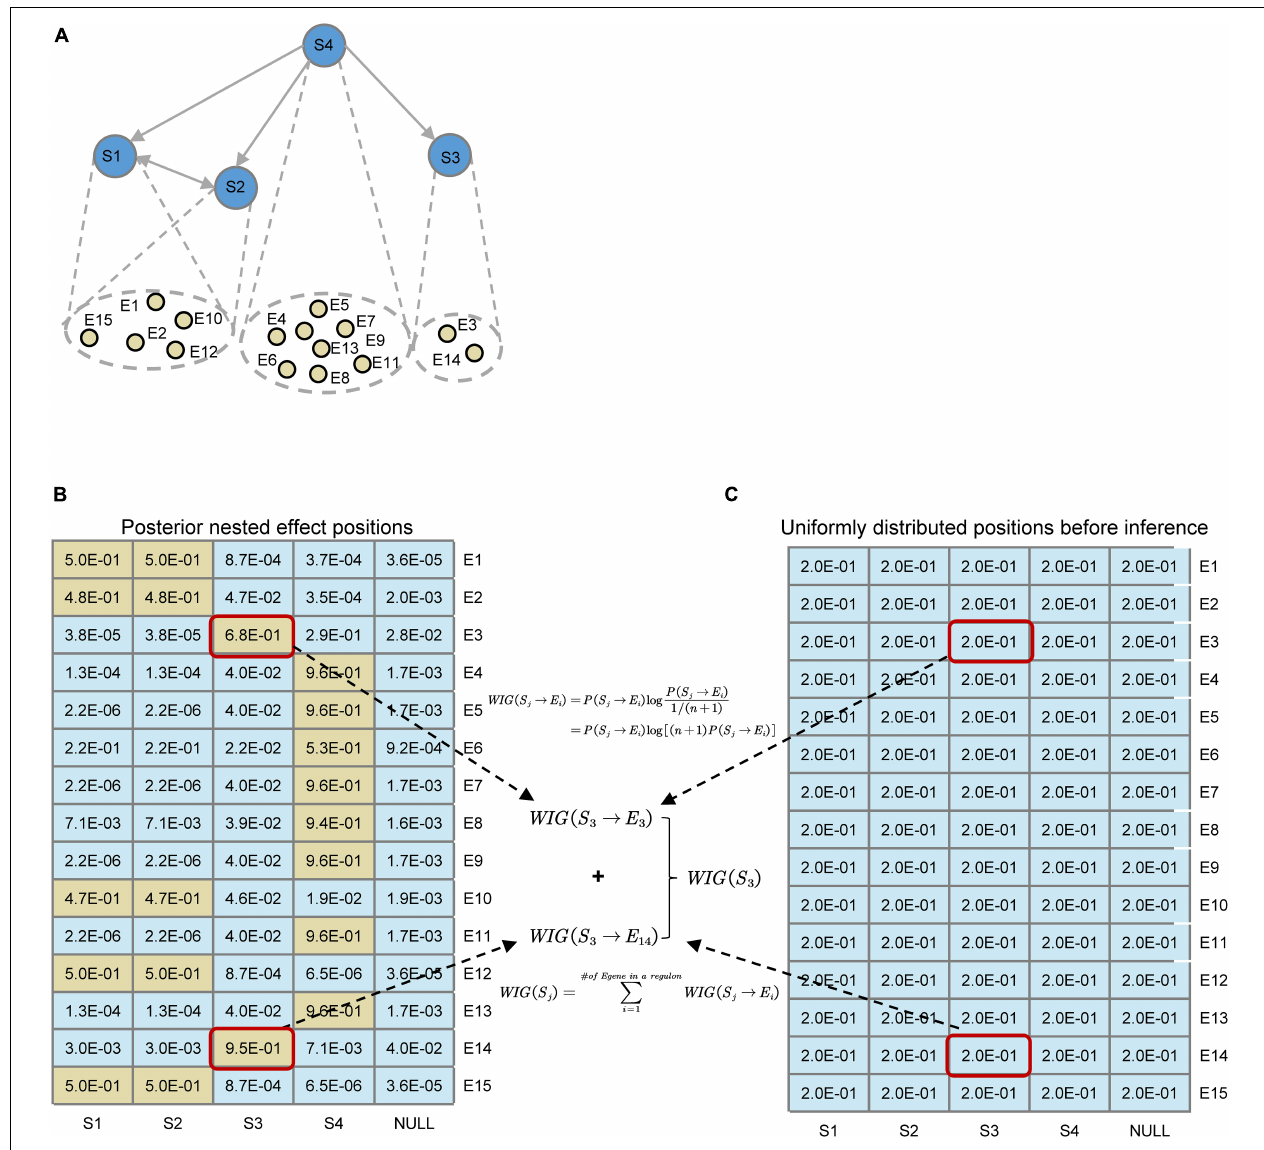
FIGURE 3 | Illustration for the definition of Weighted Information Gain (WIG) using a toy example. (A) A toy network containing four S-genes with their corresponding E-gene attachment. Note that the hierarchies of S1 and S2 genes cannot be distinguished. (B) Posterior effect positions obtained after network inference; (C) Uniformly distributed effect positions before inference. Suppose that the attached E-genes to a S-gene are all signature genes related to a pathway of interest (e.g., EMT), it could be easily calculated that S 4 has the highest causal impact on the particular downstream pathway, and S 1 and S 2 have the same impact. As an example, we illustrated the calculation of WIG (S 3